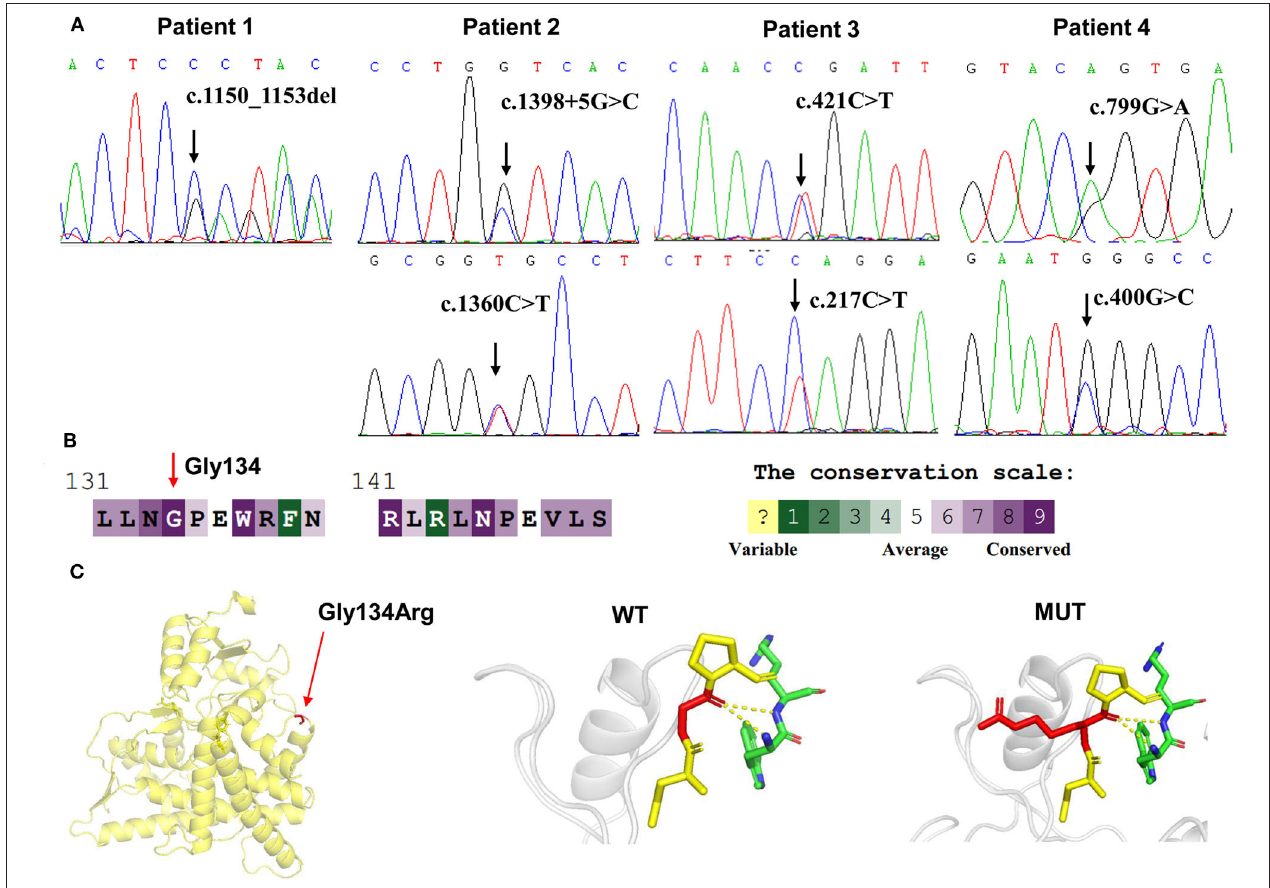
FIGURE 1 | CYP11B1 gene variants identified in 11 β OHD patients. (A) Sanger sequencing analysis showing the CYP11B1 gene mutations in four patients. Arrow indicates the mutation site. (B) The evolutionary-conservation scores for residues’ (p.Gly134Arg) mutation from different species from the UniRef 90 database. (C) Structural visualization of the identified CYP11B1 missense alteration using X-ray structure of the human CYP11B1 as a template (PDB accession number: 6M7X). The residues present at our mutation sites are shown as